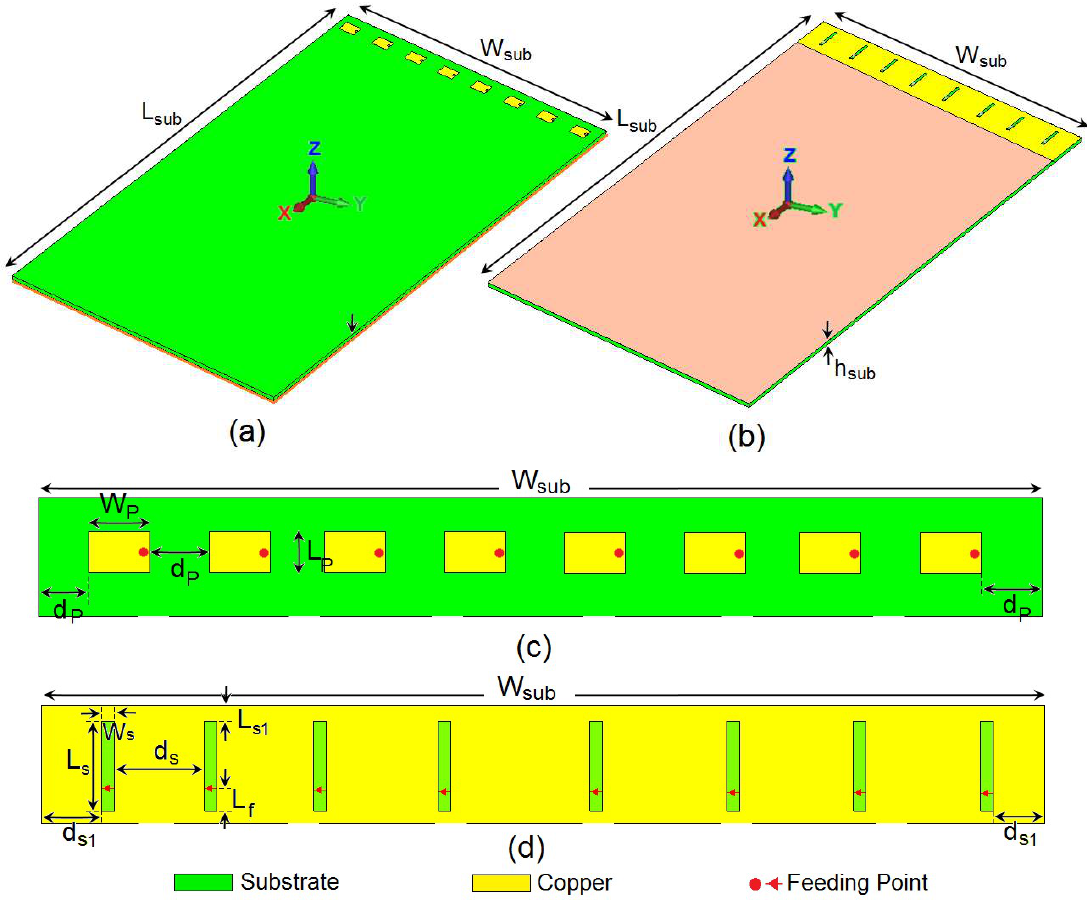
Figure 13. Side views of the smartphone mainboard with conventional ( a ) patch and ( c ) slot array antenna, ( b ) the detailed ( c ) patch, and ( d ) slot array arrangements.